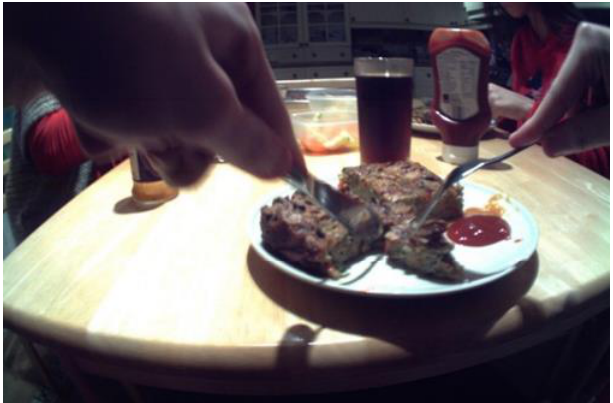
Figure 3. An example of cultural whole grain varieties consumed by participants at home: a bulgur- based